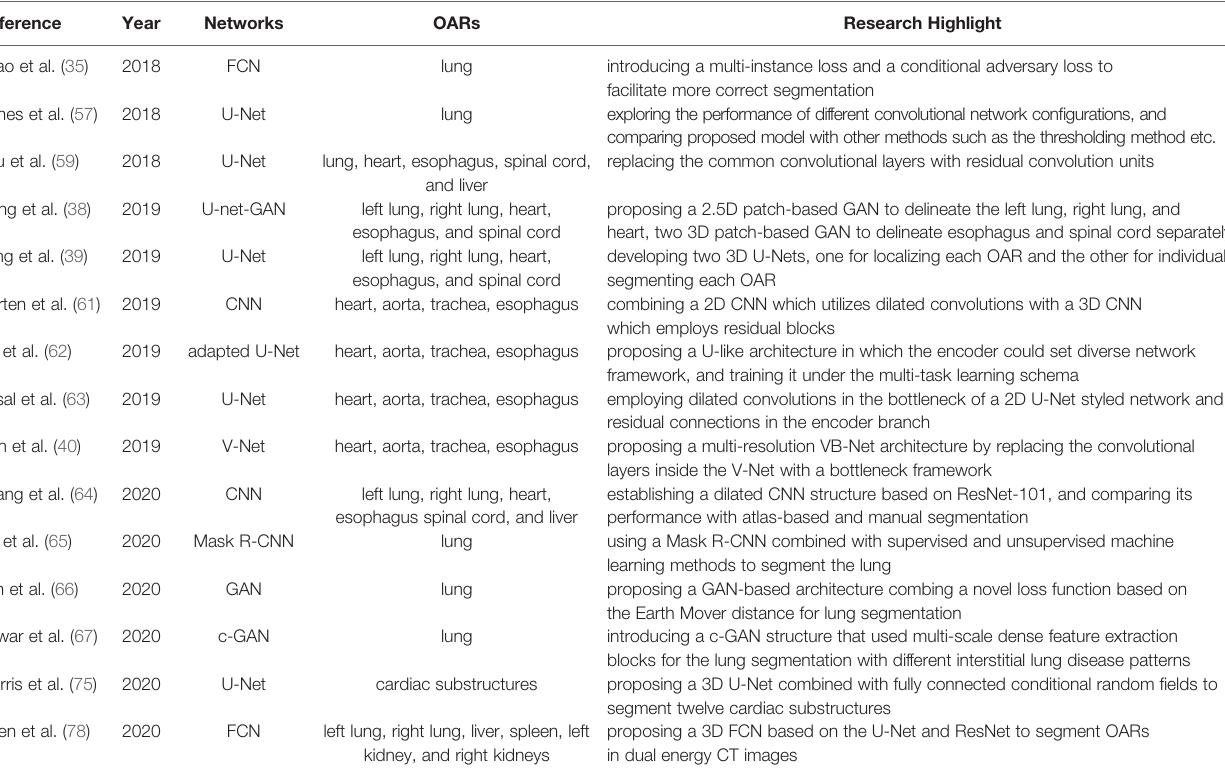
TABLE 1 | Selected works on deep learning-based automated segmentation of OARs for lung